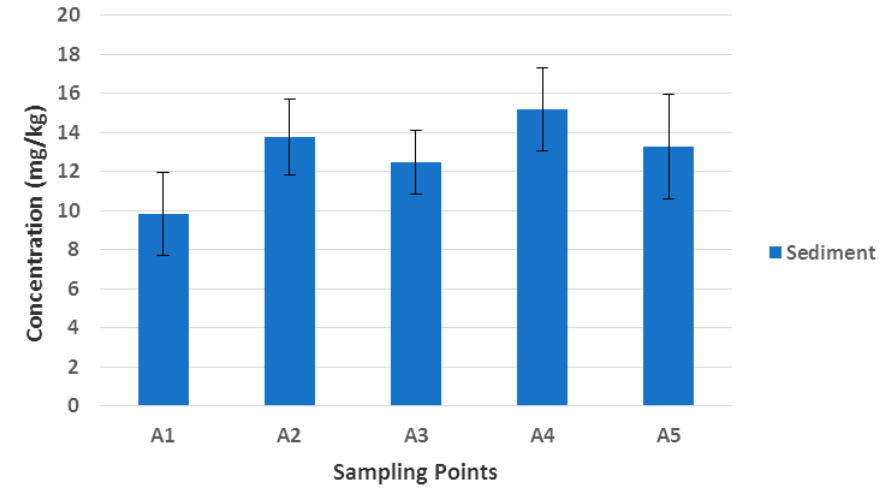
Figure 3. Spatial variation of TPH in the Algoa Bay sediment samples.